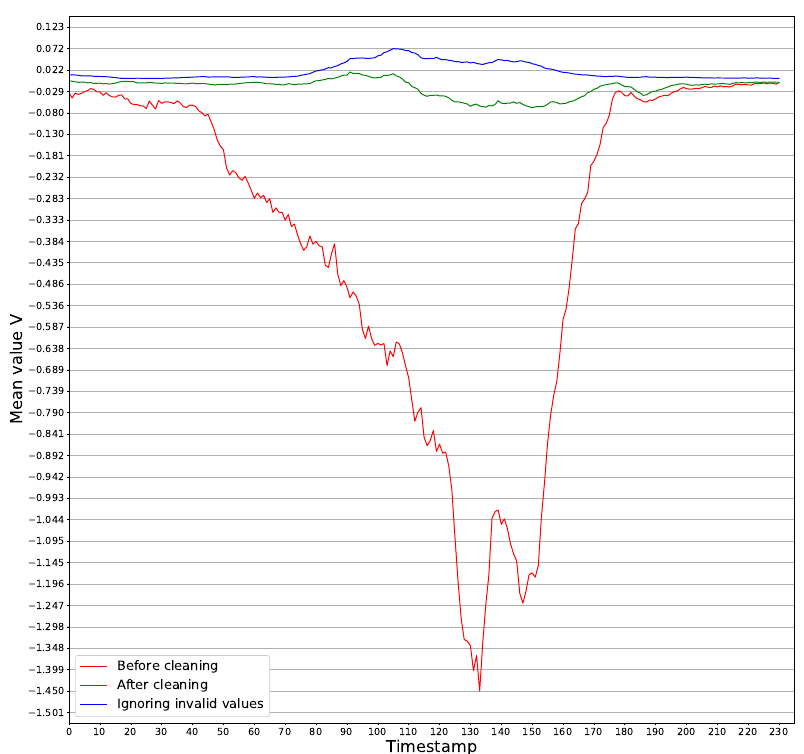
Figure 5. Time series plot for mean V values: ignoring invalid values, before and after cleaning.